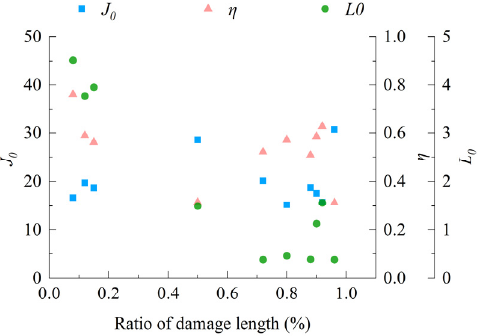
Figure 10. Relationship between gradient change and the ratio of sedimentary damage length.